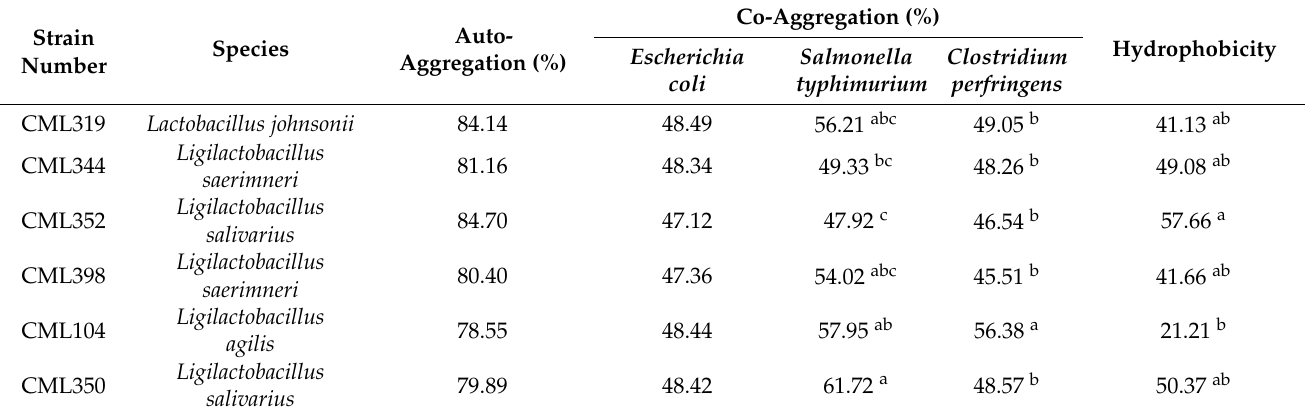
Table 6. Auto and co-aggregation ability and Hydrophobicity of lactic acid bacteria